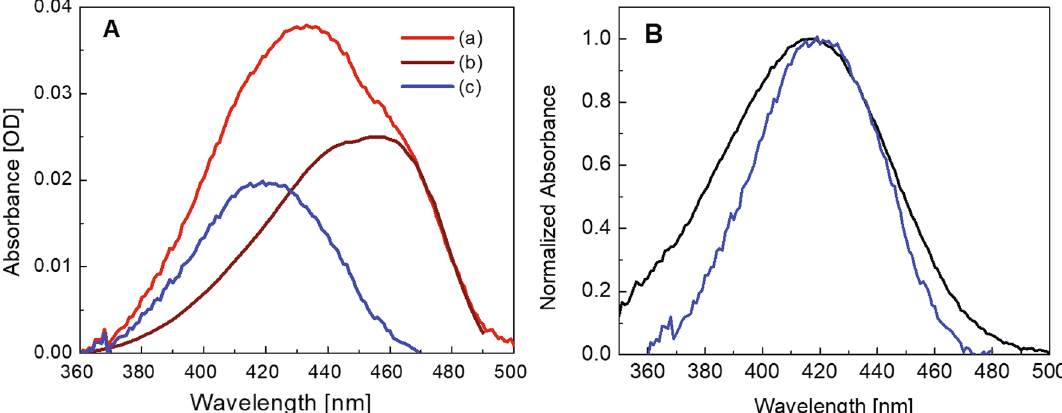
Figure 3. Absorption spectra of the system DFHBI/bSP at saturating conditions 2 µM DFHBI/20 µM bSP. (A) (a) Measured absorption spectrum of the mixture Fig. 1A (red), (b) calculated absorption spectrum